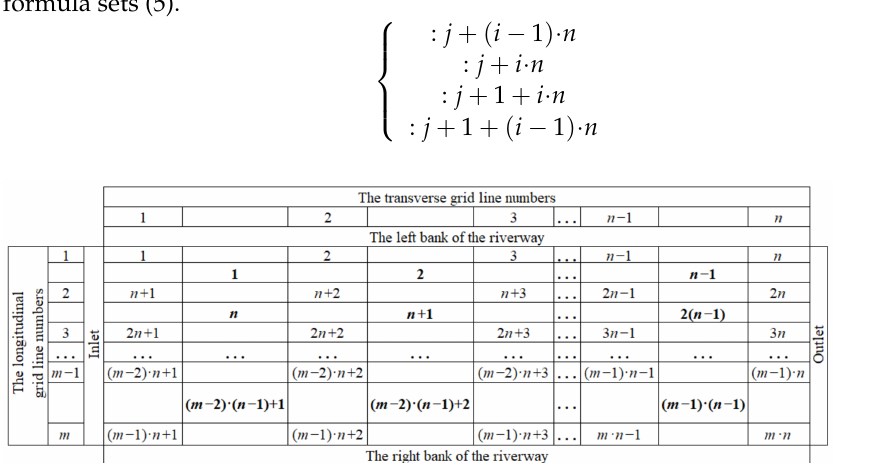
Figure 9. Coding rules of nodes and cells in the MIKE21 quadrilateral grid file (The rows marked “1, 2, . . . , m ” represent longitudinal grid lines; the columns marked “1, 2, . . . , n ” represent longitudinal grid lines; the bold values in the figure are the cell numbers; and the values at the four corners of the bold values are the node numbers.).